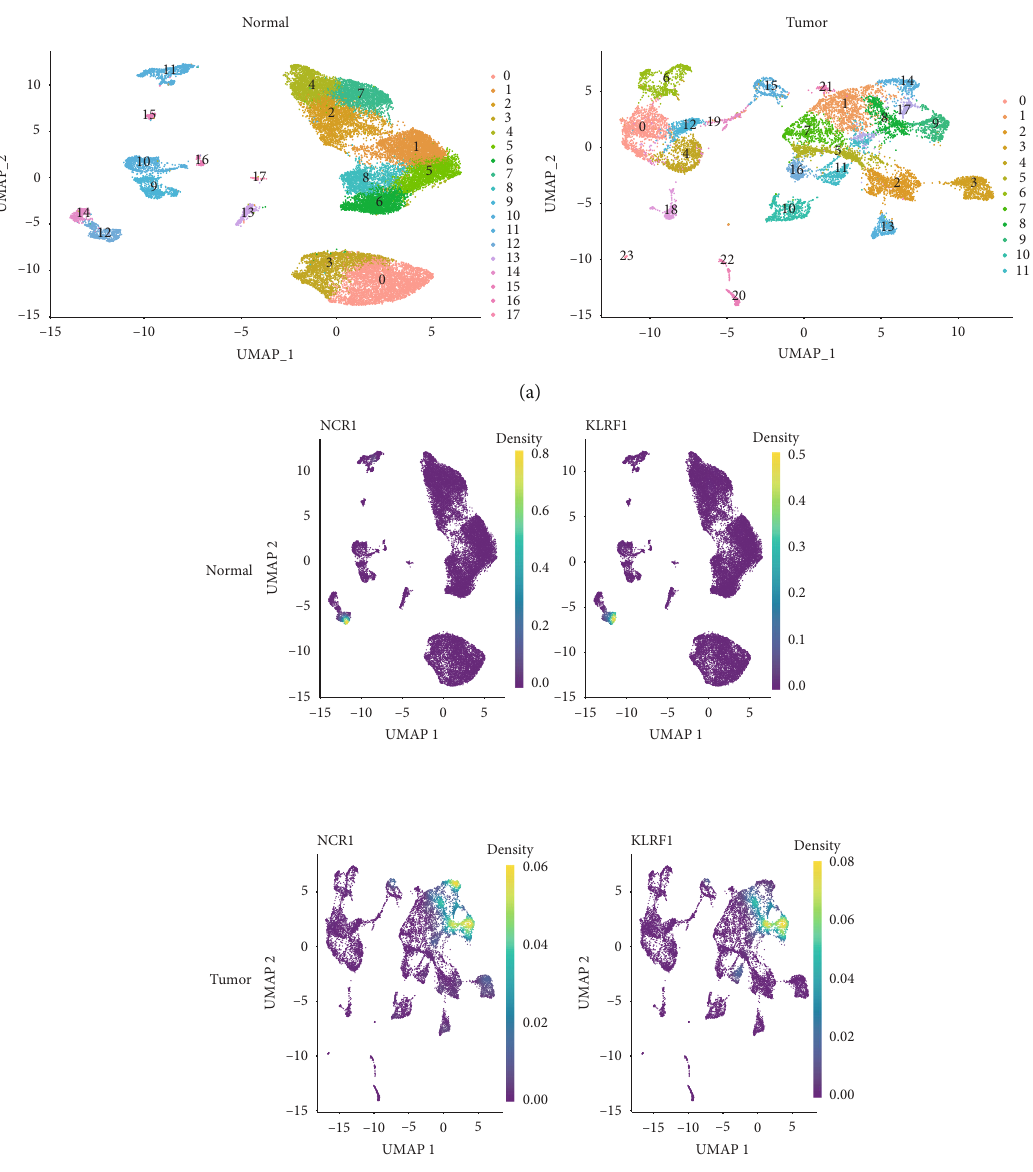
Figure 1: Isolation and identi fi cation of natural killer (NK) cells. (a) UMAP plot showing 18 cell types in normal human kidney tissues and 24 cell types in clear cell renal cell carcinoma (ccRCC). (b) Nebulograms showing that NK cell markers (NCR1 and KLRF1) are preferentially expressed in cluster 12 in normal kidney tissues and clusters 8, 9, 14, and 17 in